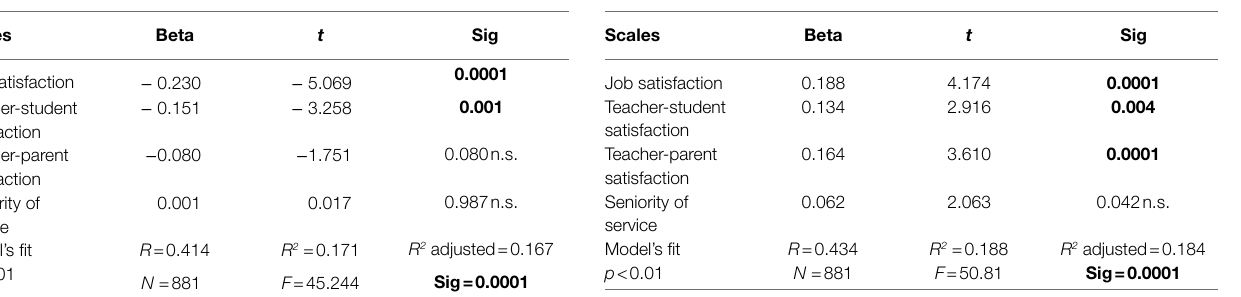
TABLE 3 | Regression